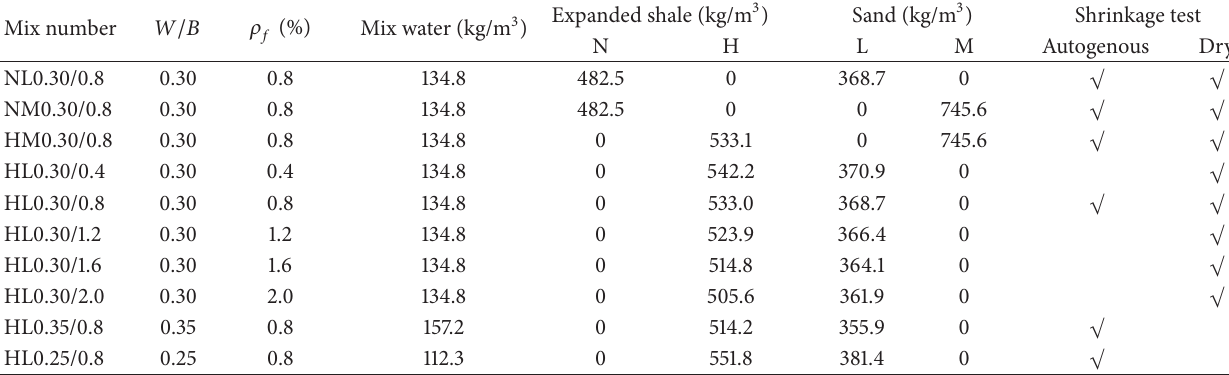
Table 5: Parameters of shrinkage tests and mix proportion of concrete.